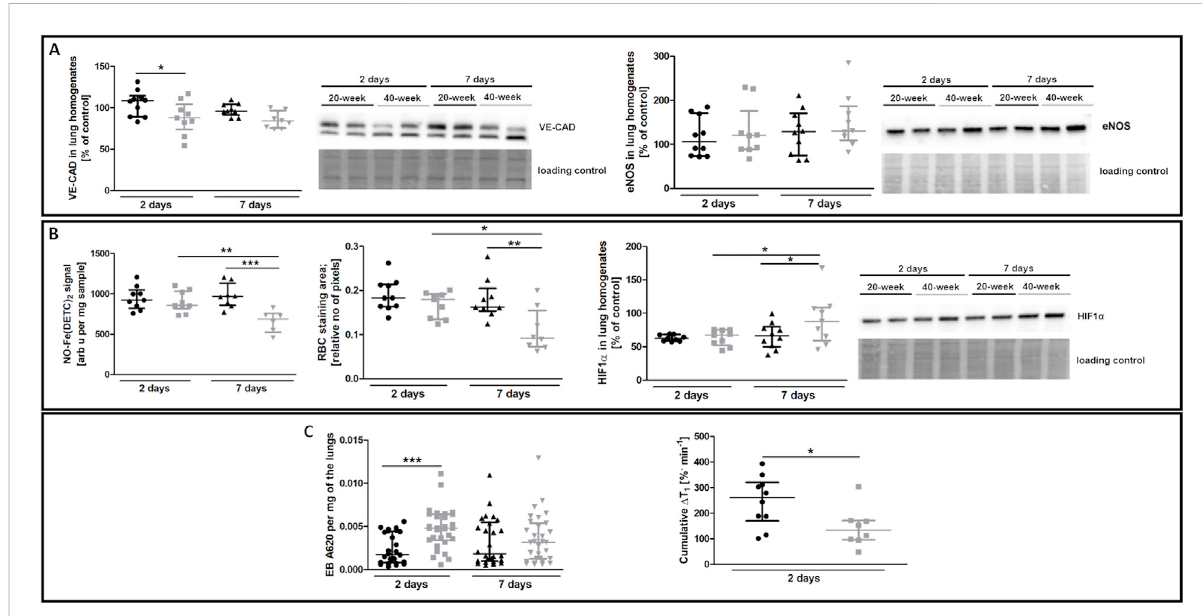
FIGURE 8 EndMT biomarkers and functional parameters in the lungs of 4T1 breast cancer cell-injected 20-week-old and 40-week-old BALB/c mice. Black symbols denote 20-week-old mice, and grey symbols denote 40-week-old mice. (A) VE-CAD and eNOS levels in the lung homogenates of 20-week-oldand40-week-oldmicetwoandseven dayspost-injectionof4T1breastcancercellsshownbyrepresentativewesternblots( n =9 – 10). (B) TheiNOS-independentNOproduction( n =6 – 10),RBCstainingarea( n =8 – 10),andHIF1 α levels( n =9 – 10)inthelungsof20-week-oldand 40-week-old mice two and seven days post-injection of 4T1 breast cancer cells are shown by representative western blots. (C) Changes in lung permeability indicated by EB dye deposition in the perfused lungs of 20-week-old and 40-week-old mice two and seven days post-injection of 4T1 breast cancer cells ( n = 26 – 30) are shown alongside MRI-based quanti fi cation of liquid leakage from pulmonary circulation after acute L-NAME treatment(cumulative Δ